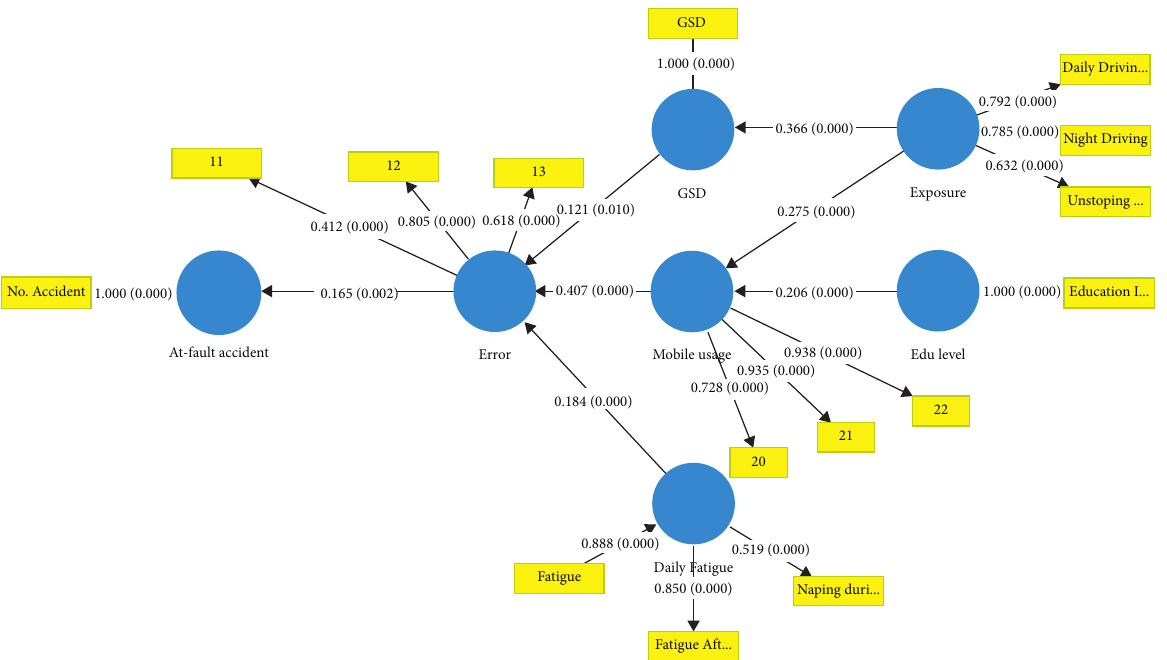
Figure 3: Full diagram with path coefficients of SEM. Table 1: The factor loadings of latent variable indexes and their statistical significance